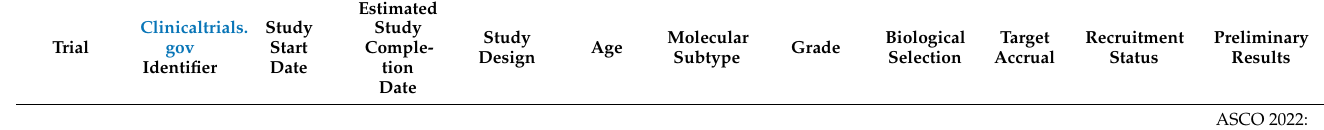
Table 2. Ongoing clinical trials for the omission of radiation therapy incorporating multigene assays.